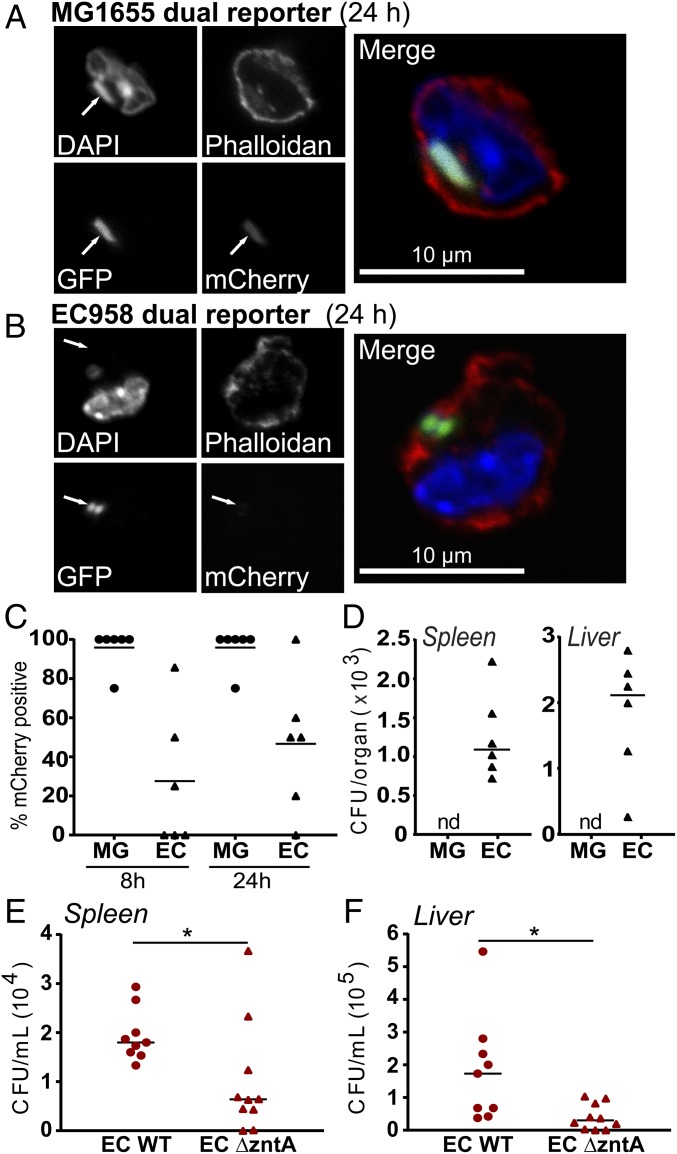
EC958 both evades and resists zinc toxicity after intraperitoneal challenge, enabling dissemination to the liver and spleen. Mice were intraperitoneally infected with 106 CFU of either the MG1655 pGcCzntAp (MG) or EC958 pGcCzntAp (EC) dual reporter strains, after which peritoneal exudates, spleens and livers were collected at 8 and 24 hpi. Representative images from infiltrating peritoneal cells at 24 hpi containing (A) MG1655 or (B) EC958, stained with DAPI (nucleus) and Phalloidan-647 (actin). (Magnification: 63×.) (C) For each bacterial strain, the percentage of GFP+ bacteria that were also mCherry+ was calculated in peritoneal exudates (horizontal bars indicate mean, n = 6 mice per group from two independent experiments). (D) Spleens and livers from infected mice were collected and chloramphenicol-resistant CFU/organ were determined (horizontal bar indicated median, n = 6 mice per group). nd, not detectable. (E and F) Mice were intraperitoneally infected with 107 CFU of either the wild-type EC958 or EC958 ΔzntA, after which spleens and livers were collected at 20 hpi. Organs were homogenized and the CFU/organ were determined (horizontal bars indicate median, n = 9 mice from two independent experiments). *P < 0.05, Welch’s t test.